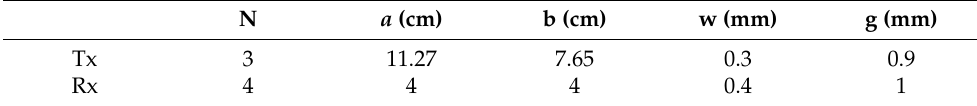
Table 1. Dimensions of the obtained coils using the proposed efficiency optimization method.